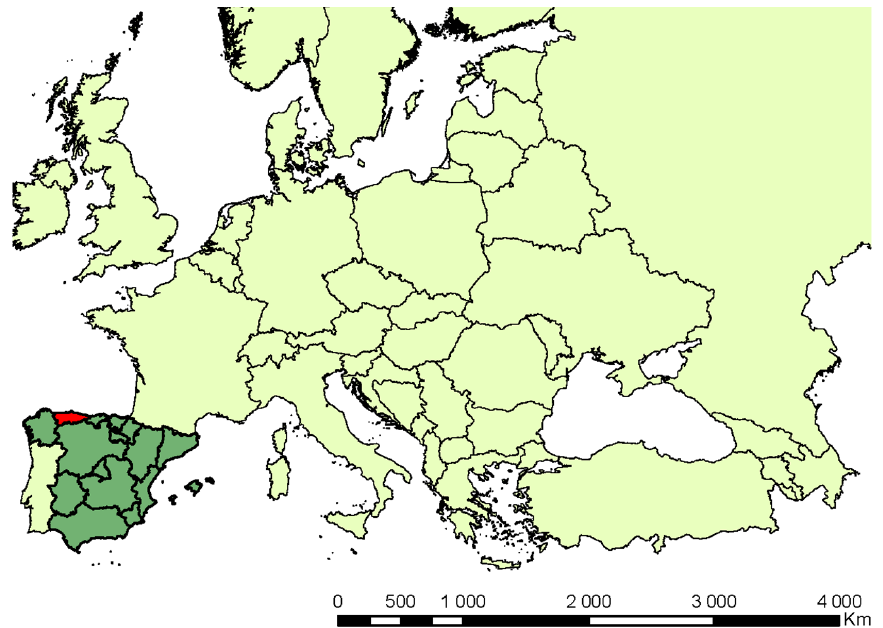
Figure 1. Geographical situation of the Principality of Asturias (red) in Spain (dark green) and within Europe.